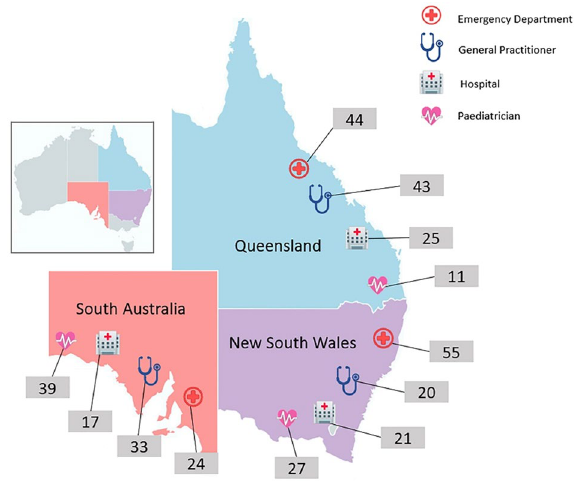
Figure 1. GORD assessments by state and health care provider type. Total number of visits to Emergency Departments = 123; total number of visits to General Practitioners = 96; total number of admissions to hospital = 63; total number of visits to Paediatricians = 77. Total number of GORD assessments in: New South Wales = 123; Queensland = 123; and South Australia = 113. Total number of visits assessed for care of GORD in sampling frame = 359. [Map outline from https:// mapch art. net/, Creative Commons Attribution-ShareAlike 4.0 International License, with data added by the authors in Microsoft PowerPoint for Microsoft 365 MSO Version